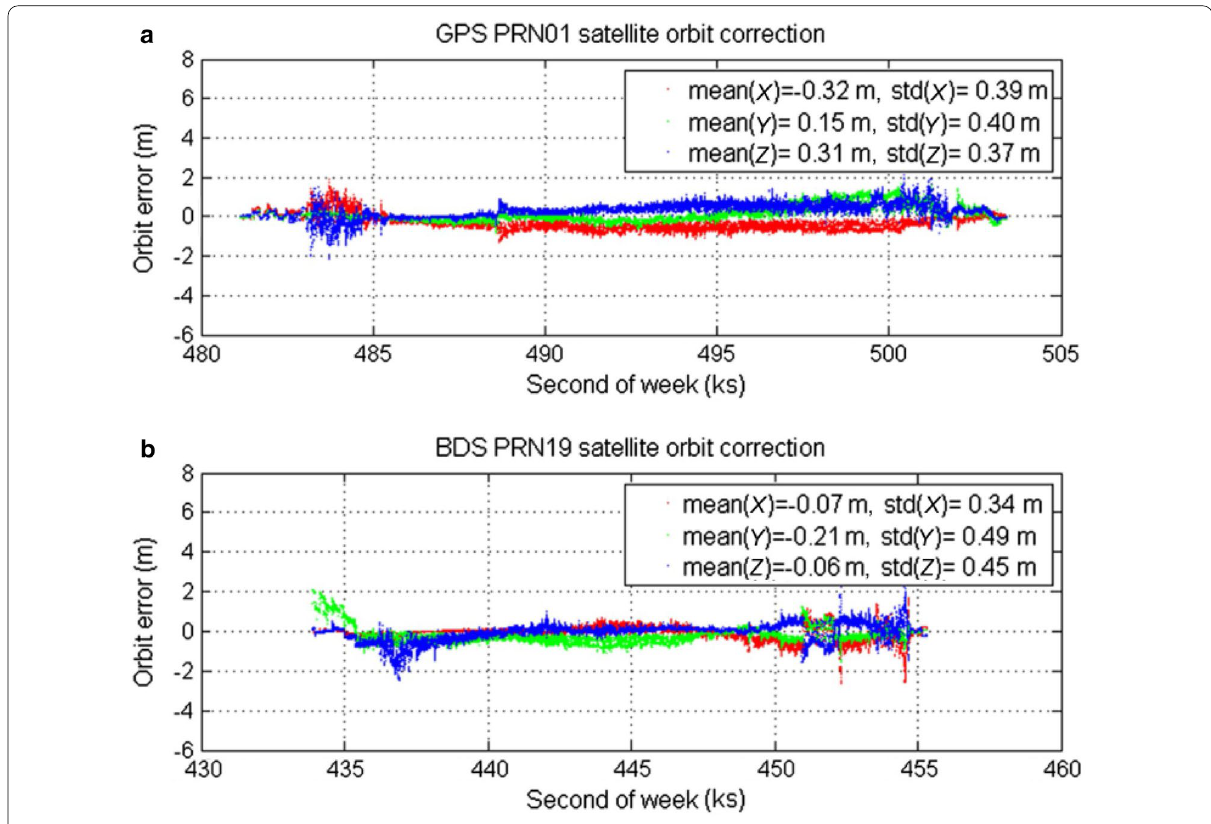
Fig. 7 Long-term orbit corrections of GPS PRN01 and BDS PRN19